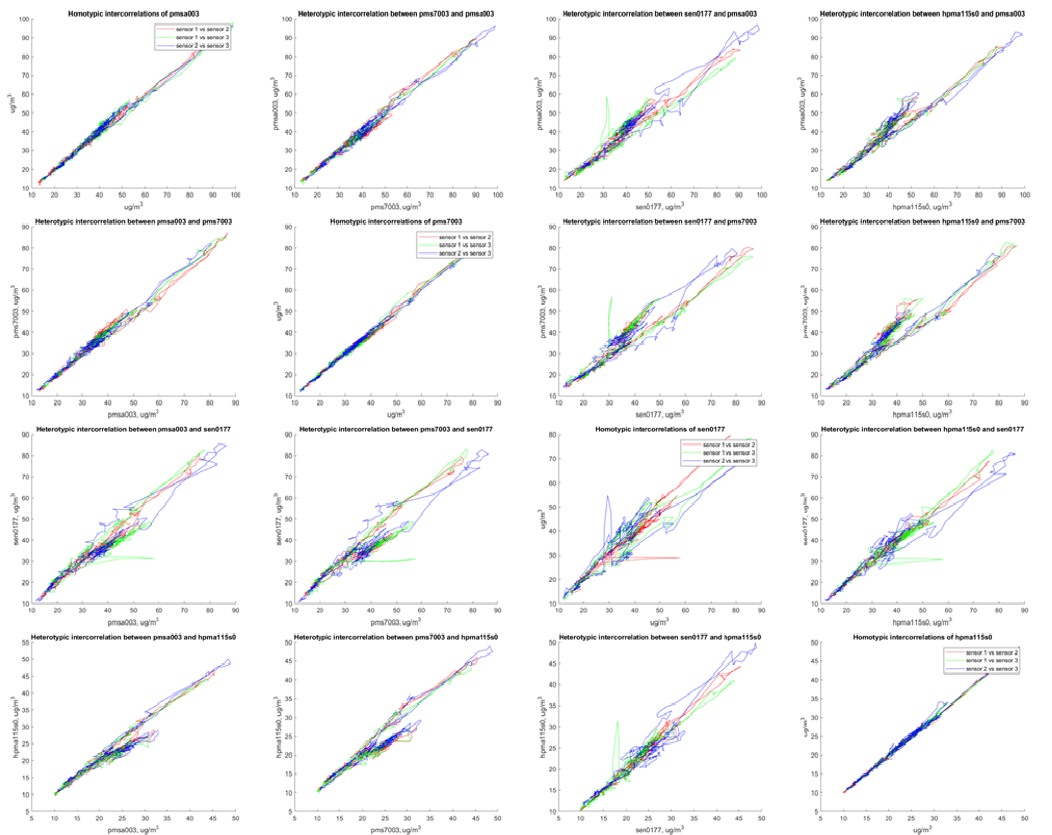
Figure A3. Information on governmental BAM and test environment. The BAM is located at 426, Hakdong-ro, Gangnam-gu, Seoul, Korea and operated by the Seoul research institute of public health and environment.